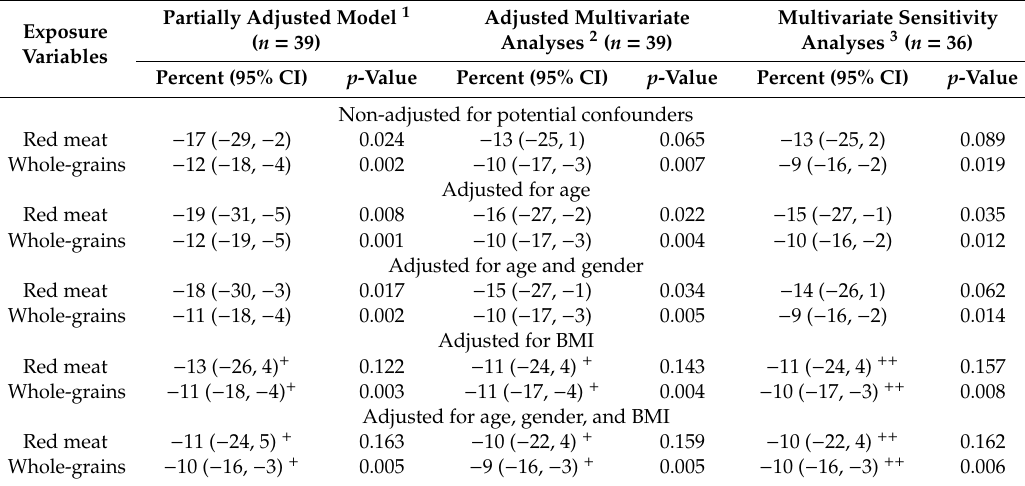
Table 4. The change in mucus thickness in biopsies from colon sigmoideum (percent) per 100 g di ff erence in red meat or whole-grain intake.